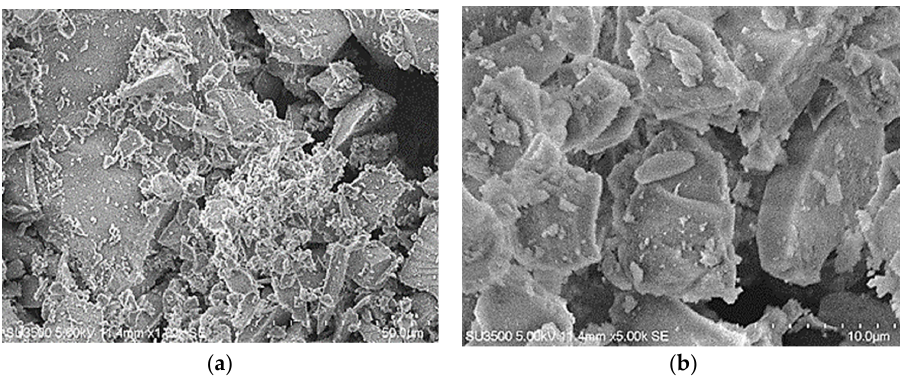
Figure 3. SEM images of ( a ) SiO 2 and ( b ) SS0.4 catalyst at 5000 × magnifications. The elemental composition analysis of SiO 2 , SS0.4, and Ni-SS1 catalysts is shown in